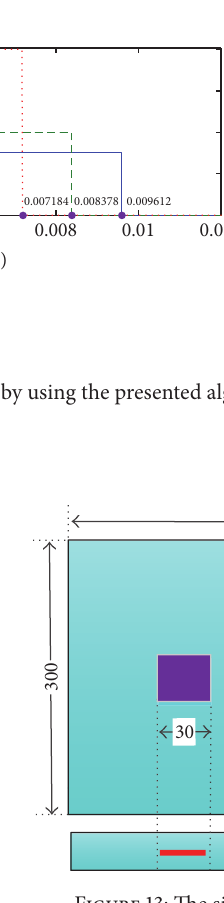
Figure 13: The size diagram of the